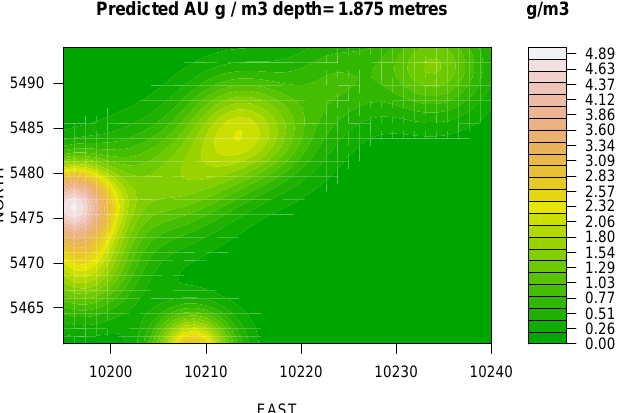
Figure 2. Predicted production target favorability map in Au g/m 3 at depth = 1.875 m, where high grades contrasting with low grades. Model indicates the presence of a developing trend towards North-East direction with overall increase of grade and the existence of internal dilution in SE and E directions assigned the color